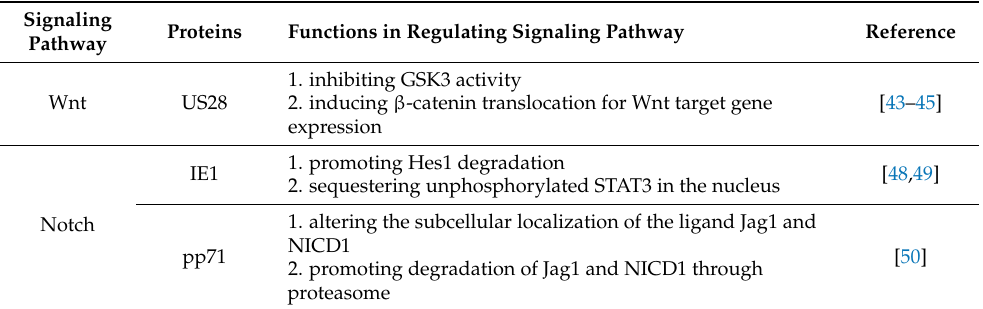
Table 2. Viral proteins of HCMV involved in the Wnt and Notch signaling